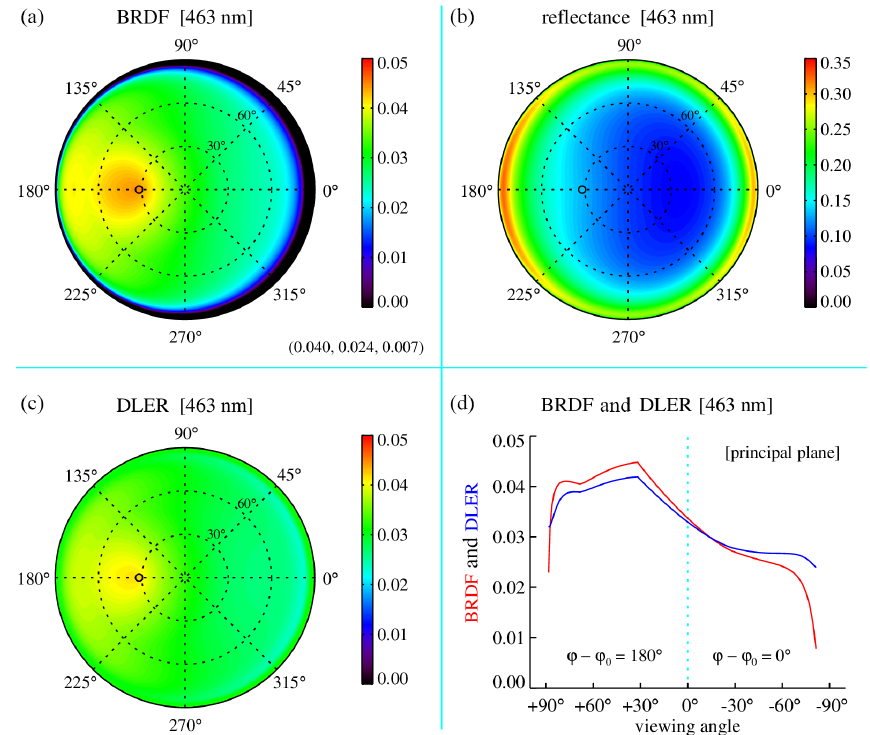
Figure 4. Similar to Fig. 3 but now for 463nm. Note that the BRDF kernel coefficients are different from the ones in Fig. 3. The relative differences between DLER and BRDF are now larger, especially near the hot spot and for large viewing zenith